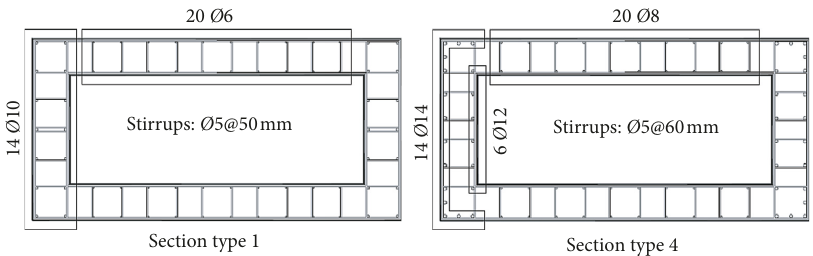
Figure 5: The reinforcement of piers section types of b213 bridge [16].